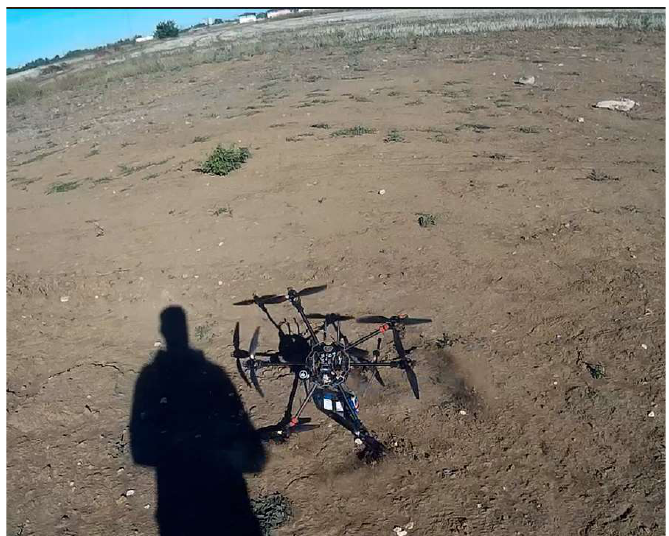
Figure 44. Hexacopter impact during field tests.